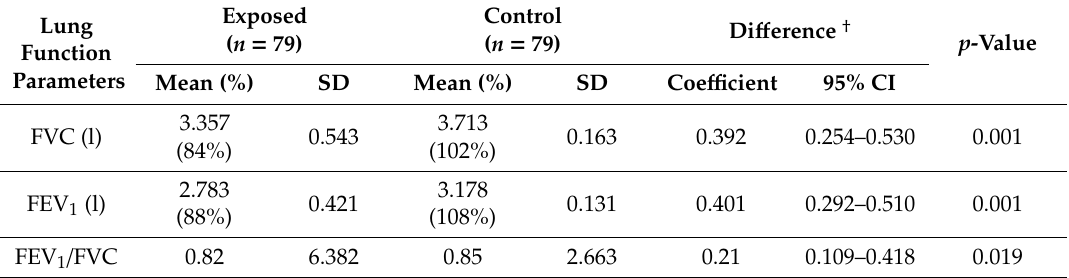
Table 4. Means and adjusted di ff erences in lung function parameters between the two study groups. Lung Function Parameters